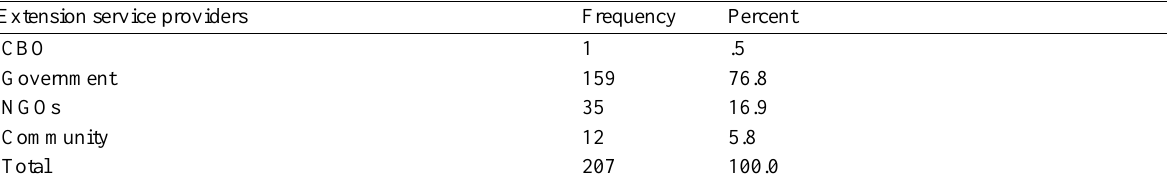
Table 4: Extension service providers